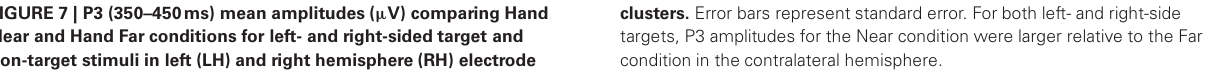
FIGURE 7 | P3 (350–450ms) mean amplitudes ( µ V) comparing Hand Near and Hand Far conditions for left- and right-sided target and non-target stimuli in left (LH) and right hemisphere (RH) electrode